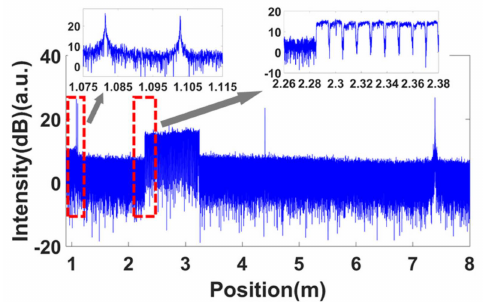
Figure 10. OFDR trace of configuration 1 with nonlinearity correction. The inset is the reflection of the PC connector.